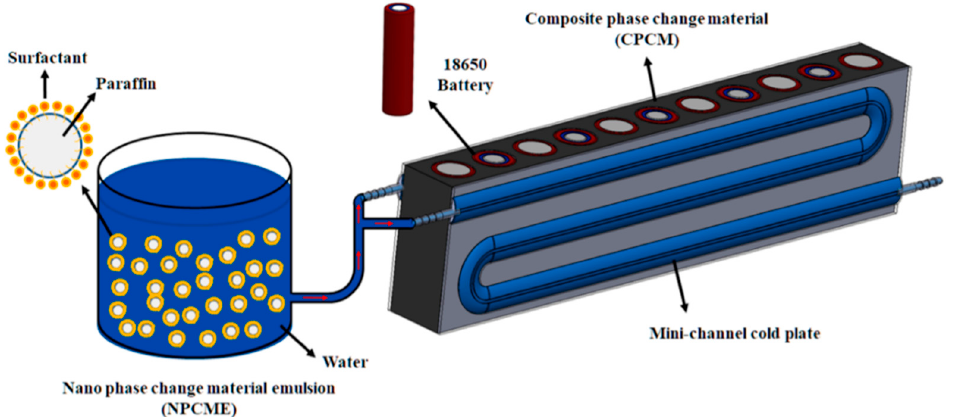
Figure 17. Conceptual diagram of coupling between phase-change material and nanophase-change material emulsion [106]. Reproduced from reference 106 with permission from Elsevier B.V., copy- material emulsion [106]. Reproduced from reference [106] with permission from Elsevier B.V., right 2021. copyright